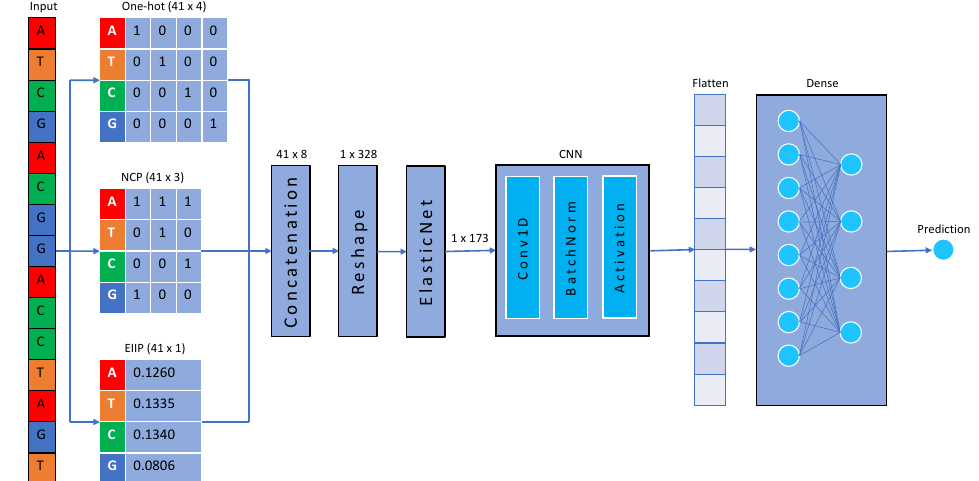
Figure 2. Framework of the proposed model, ENet-6mA.